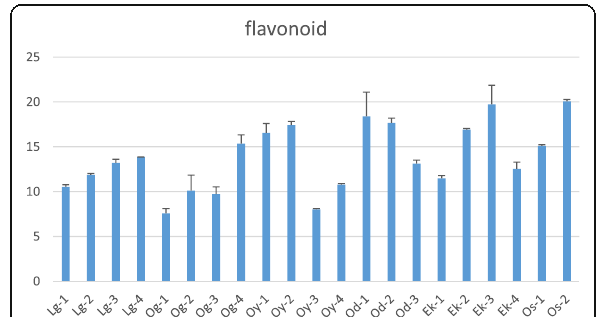
Fig. 2 Total phenolic content of Moringa oleifera leaf from the 21 locations. The results are mean of triplicates with the error bars (standard deviation). The chart shows significant between- and within- group differences in the total phenolic content of the